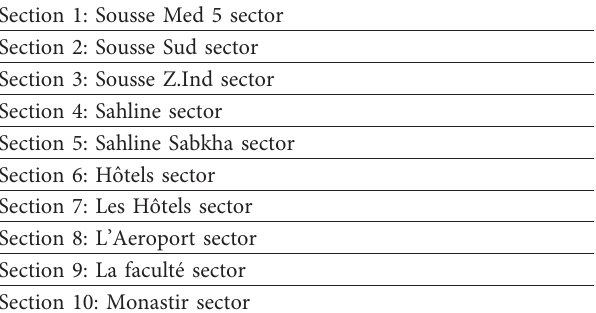
Figure 3: P-TPN model for the Sahel railway network. Table 1: Sectors of the railway network between Sousse and